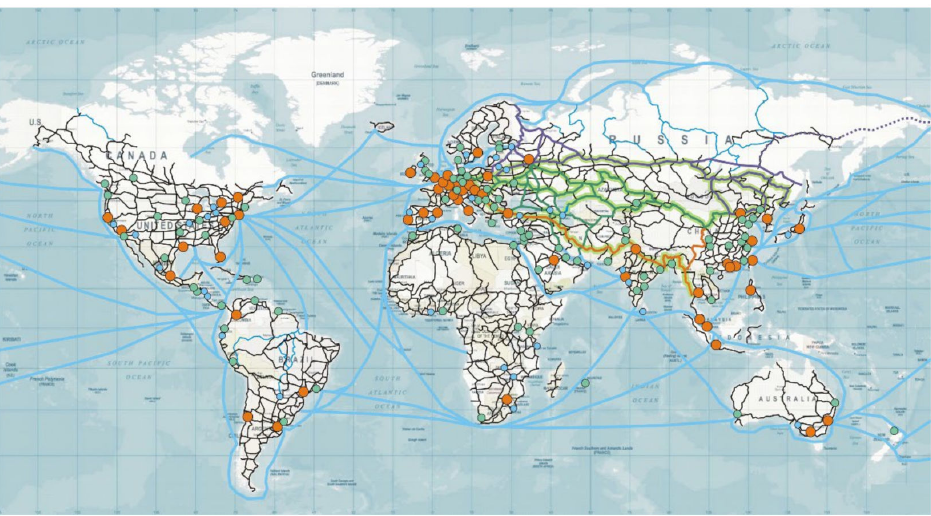
Figure 10. A model of the relationship of Eurasian transcontinental links in the global transport system and the structure of world cities according to GaWC (orange—alpha cities; green—beta cities; blue—gamma cities).